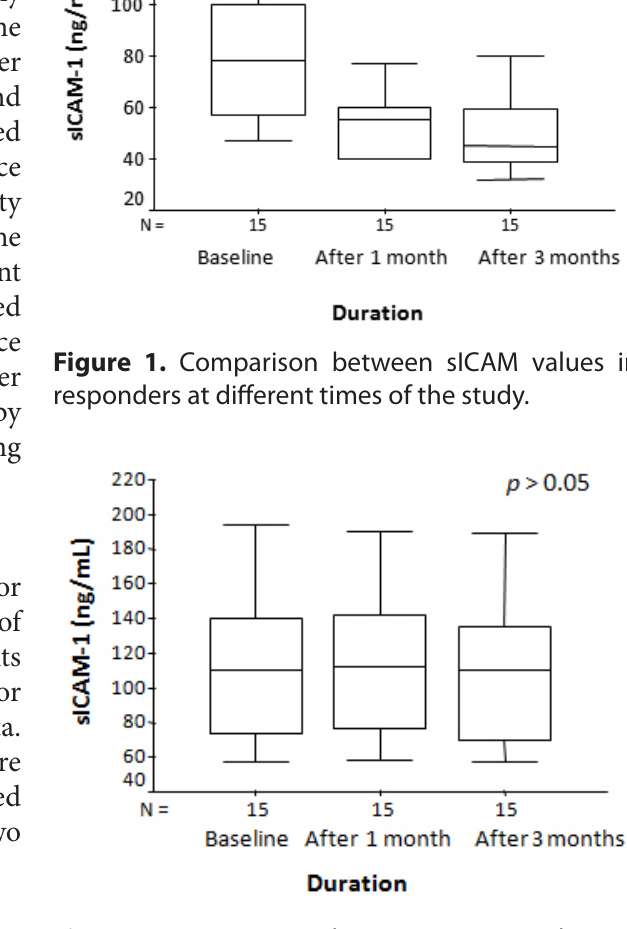
Figure 2. Comparison between sICAM values in non-responders at different times of the